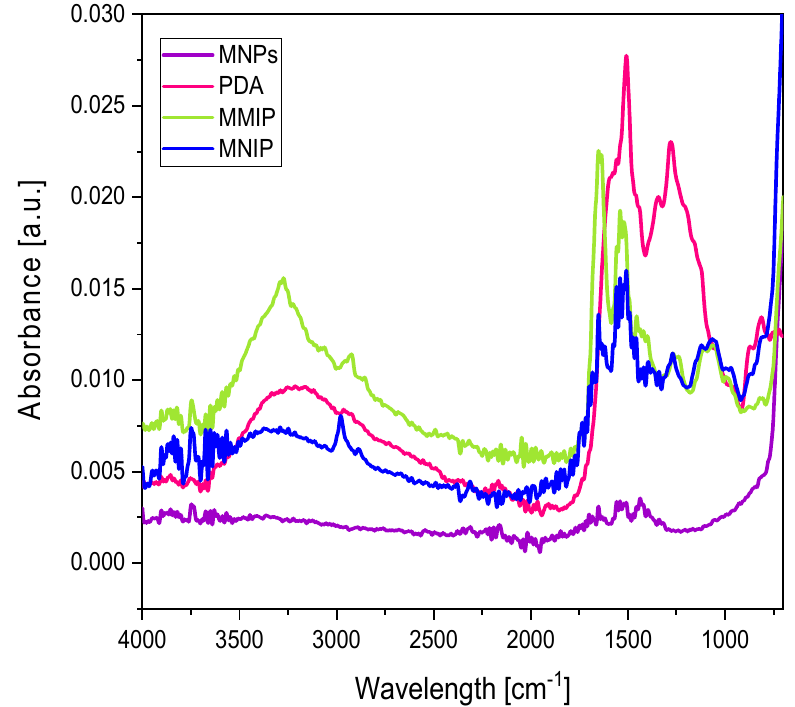
Figure 6. Fourier-transform infrared spectroscopy (FTIR) spectra of MNPs ( purple ), polydopamine (PDA) ( pink ), MMIPs ( green ), and MNIPs ( blue ).